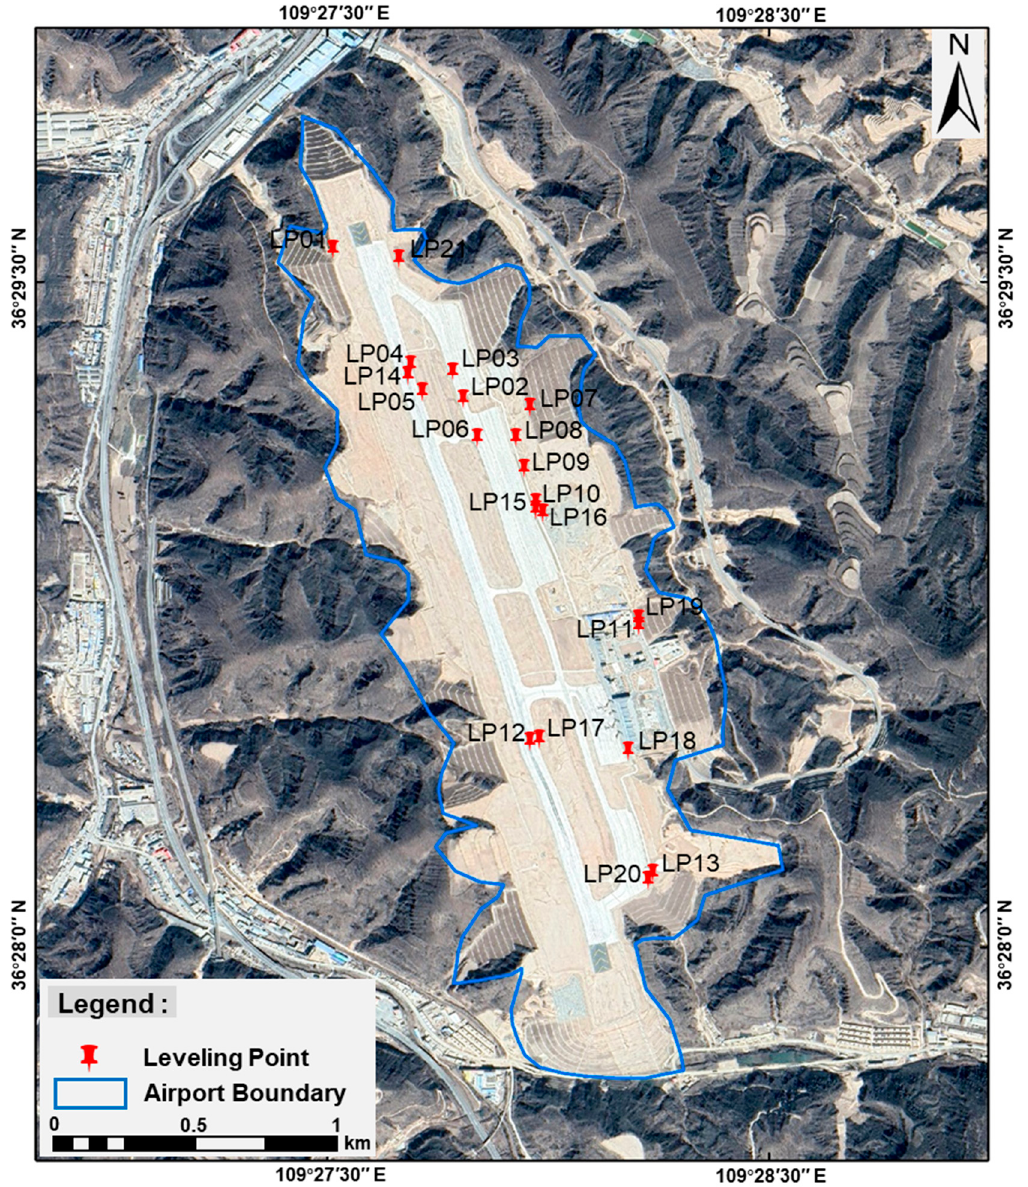
Figure 10. Distribution of leveling points in Yan’an new airport.